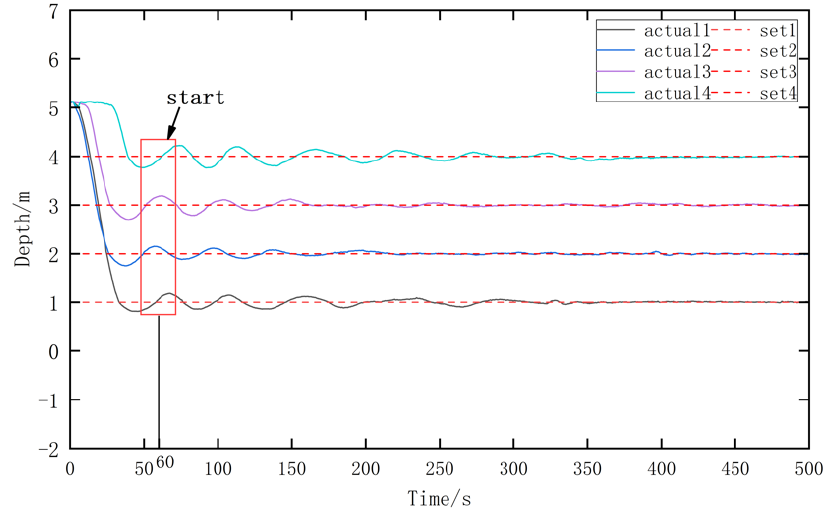
Figure 21. Depth control results in navigation mode.